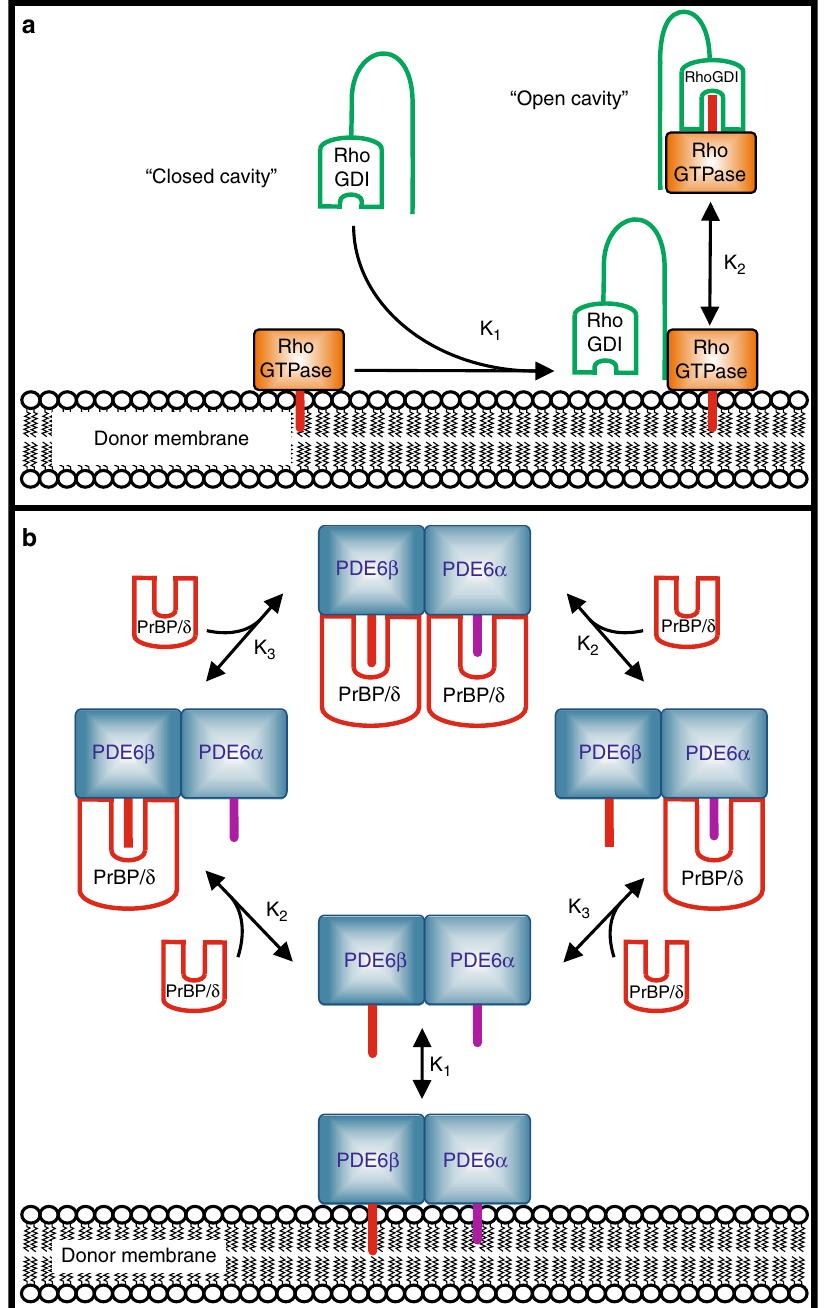
Fig. 5 Functional comparison of PrBP/ δ and RhoGDI. a Schematic model of RhoGDI-induced solubilization of RhoGTPase. The cavity of apo-RhoGDI (PDB entry 1DOA) 41 is in the closed conformation. Interaction of the N-terminal “ regulatory arm ” of RhoGDI with its binding partner on the membrane induces opening of the cavity and allows translocation of the isoprene moiety (symbolized by the red stick) of the RhoGTPase from the membrane into the cavity of RhoGDI and thereby solubilization of the RhoGTPase. b Schematic model PrBP/ δ -induced solubilization of PDE6. Apo-PrBP/ δ harbors a preshaped deep hydrophobic cavity but lacks an N-terminal domain that could function like the regulatory arm of RhoGDI. The doubly-prenylated PDE6 exists in equilibrium of membrane-associated and soluble species. Dissociation of membrane-associated PDE6 involves sequestering of soluble fraction of PDE6 by two copies of PrBP/ δ . Depletion of soluble species of PDE6 eventually leads to complete dissociation of the membrane-associated fraction ( “ dissociation by depletion mechanism ” ; see text for details). Farnesyl- (purple color) and geranylgeranyl moieties (red color) are shown as